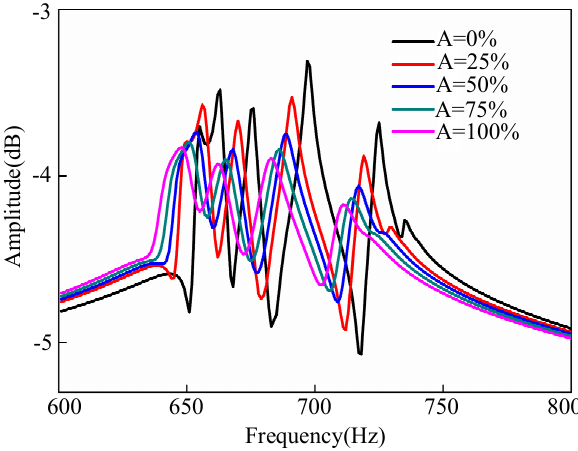
Figure 12. Frequency responses functions of mistuned blisks with different coating areas.